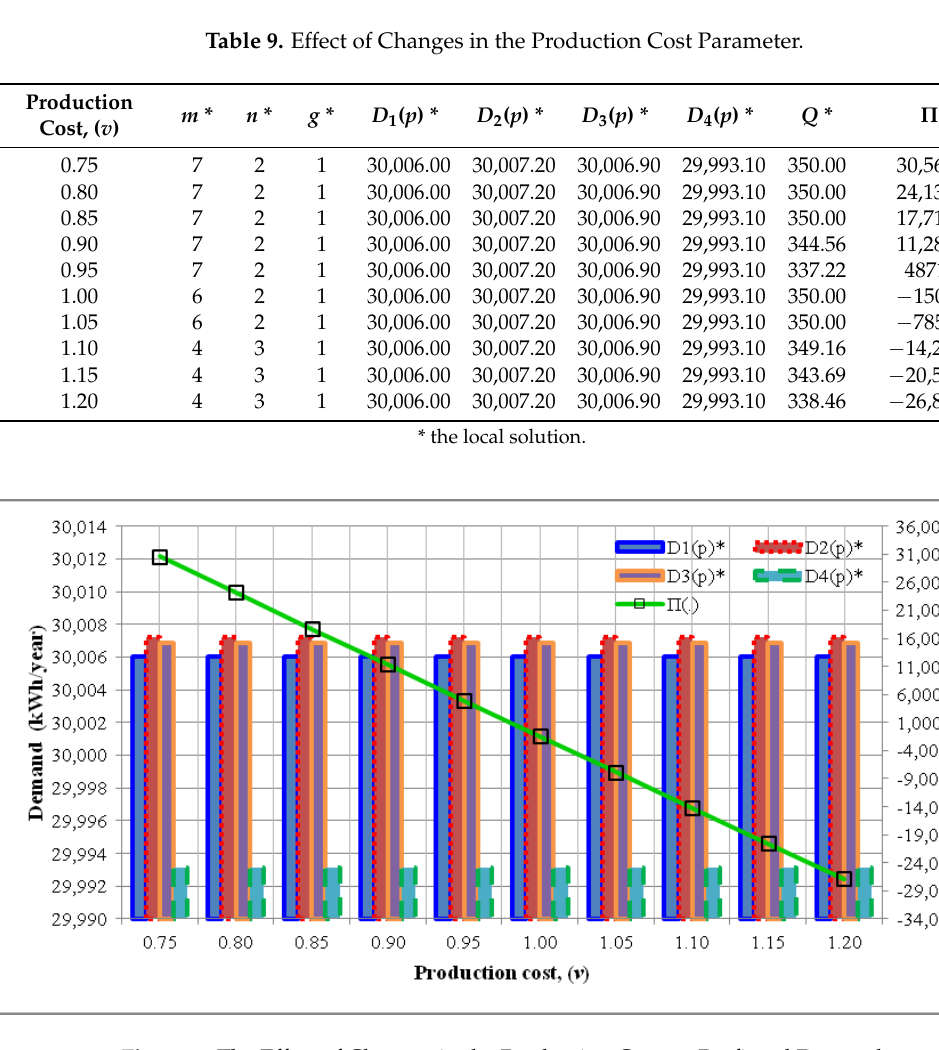
Table 10. Effect of Changes in the Power Supply Rate Parameter.